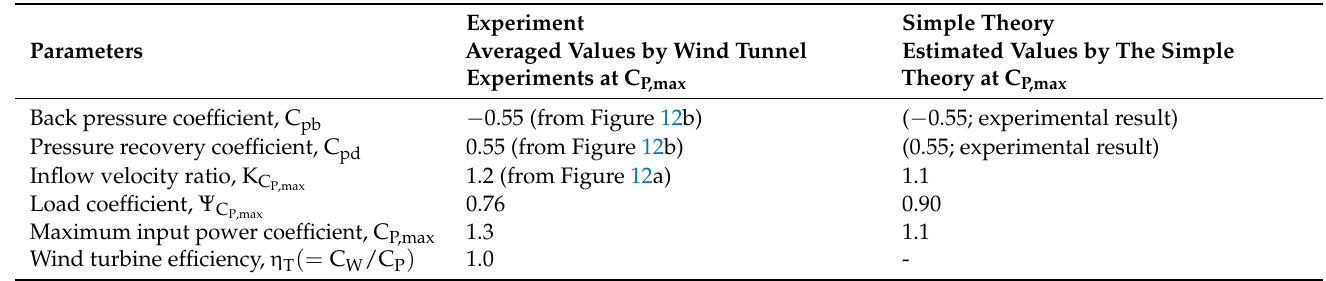
Table 2. Comparison of various coefficients between experiments and predictions by the simple theory at C P,max (at λ = 4.5) for a wind turbine with the long diffuser and large brim shown in Figure 9a.